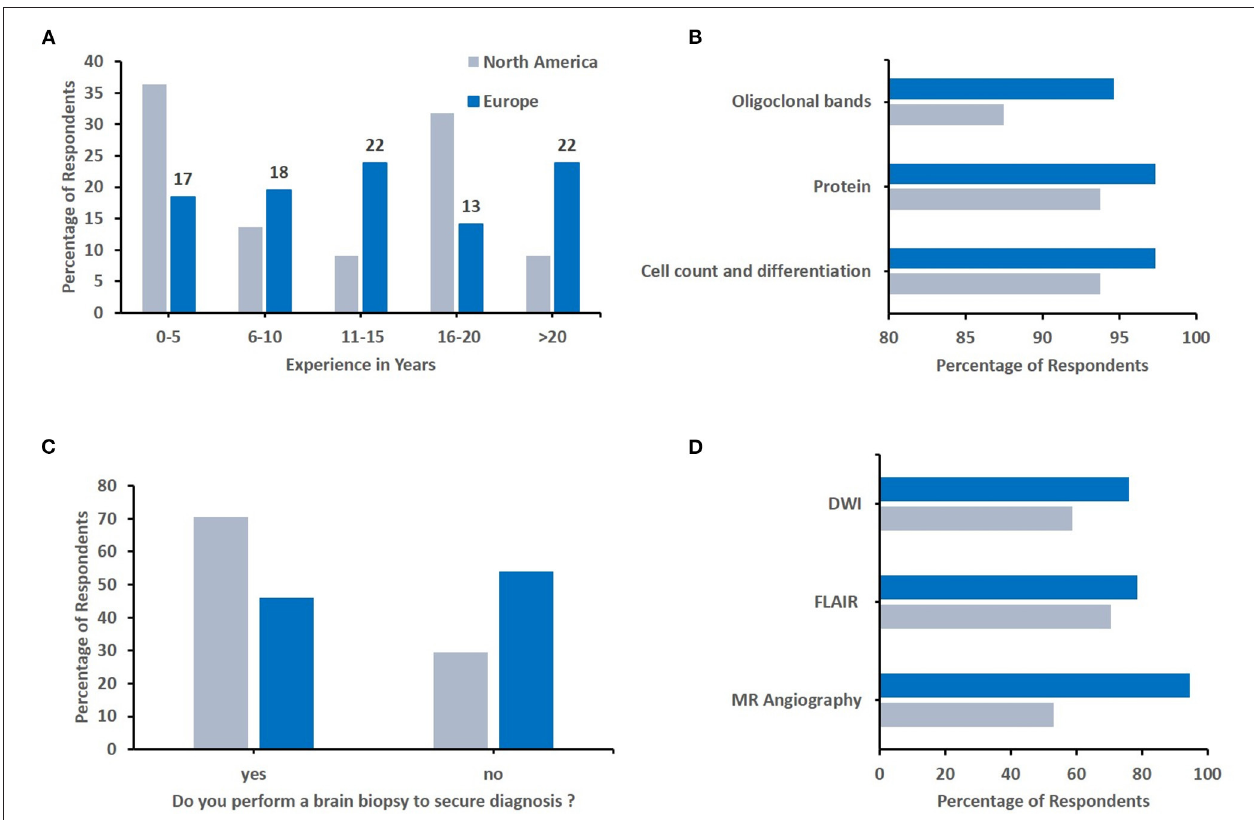
FIGURE 4 | Geographical differences in diagnostic approaches. Responses were compared between responddents from Europe and North America. (A) Number of years respondents have worked in their speciality (North America N = 22, Europe N = 92). (B) Key parameters respondents would determine from cerebrospinal fluid (North America N = 16, Europe N = 75). (C) The percentage of respondents who would/wouldn’t perform a brain biopsy to secure diagnosis (North America N = 17, Europe N = 74). (D) Sequences of the emergency MRI chosen by respondents (North America N = 17, Europe N =